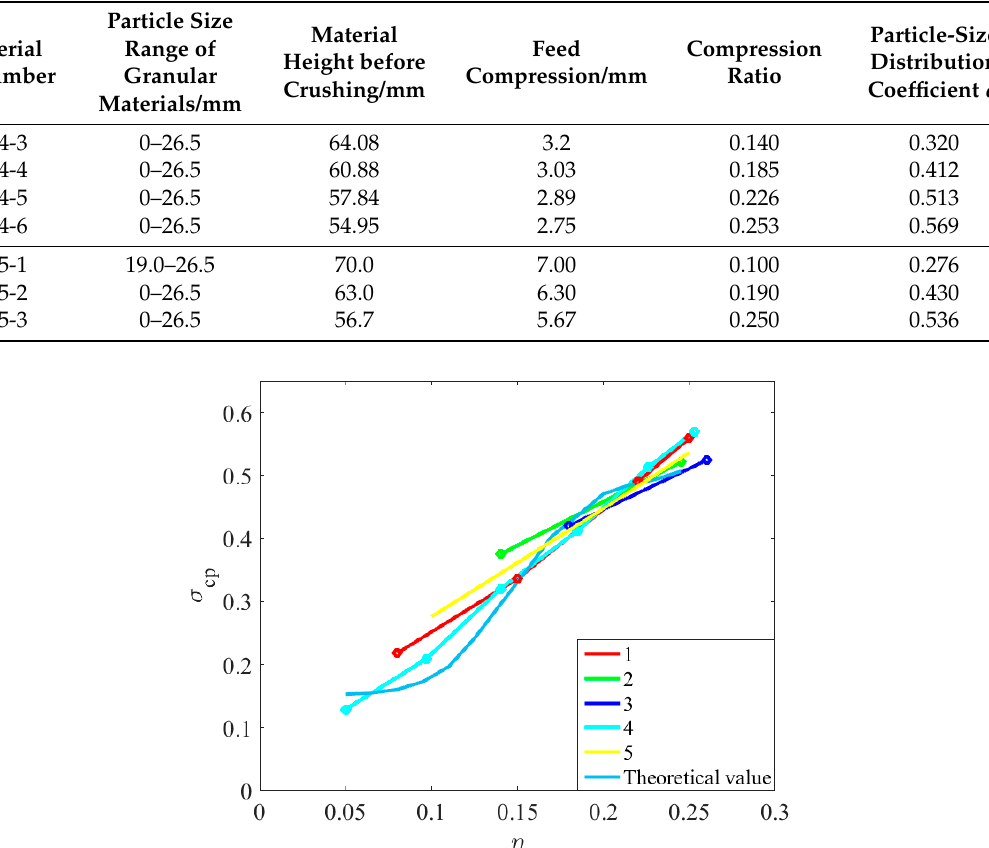
Figure 12. Particle-size distribution coefficient of theoretical and practical crushing products.